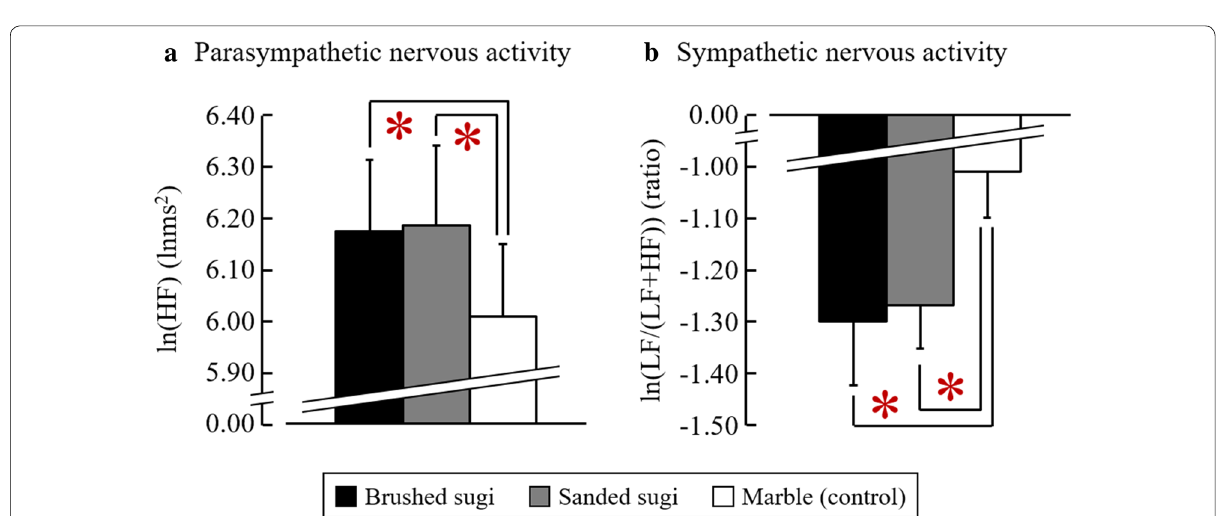
Fig. 3 Response of autonomic nervous activity indices during contact of materials via the palm of the right hand. a Overall mean of the natural logarithm of the HF component of HRV. b Overall mean of the natural logarithm of the